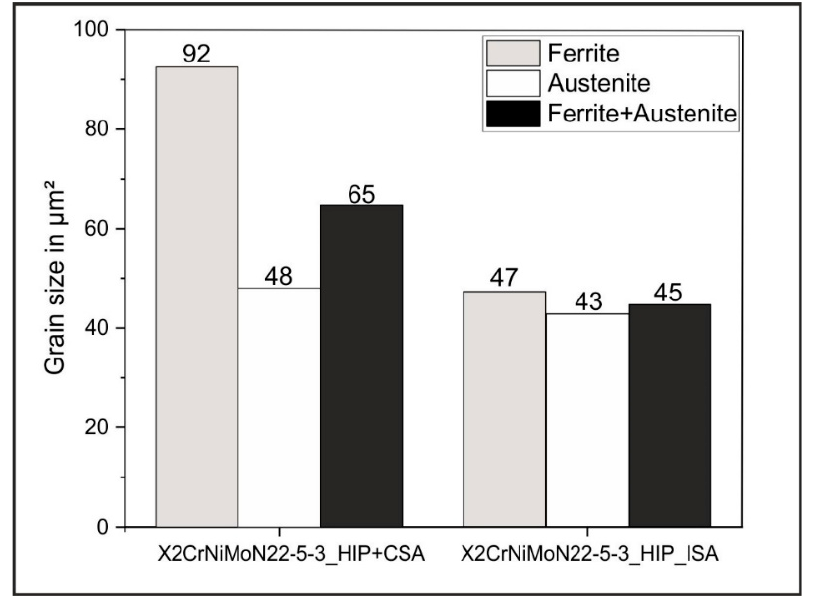
Figure 6. Grain sizes of the ferrite and austenite and overall grain sizes (ferrite + austenite) of the X2CrNiMoN22-5-3_HIP+CSA and X2CrNiMoN22-5-3_HIP_ISA steels. X2CrNiMoN22-5-3_HIP+CSA and X2CrNiMoN22-5-3_HIP_ISA